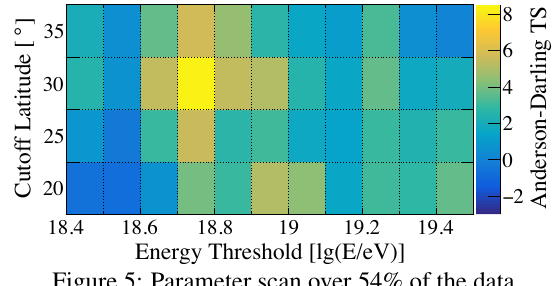
Figure 5: Parameter scan over 54% of the data.